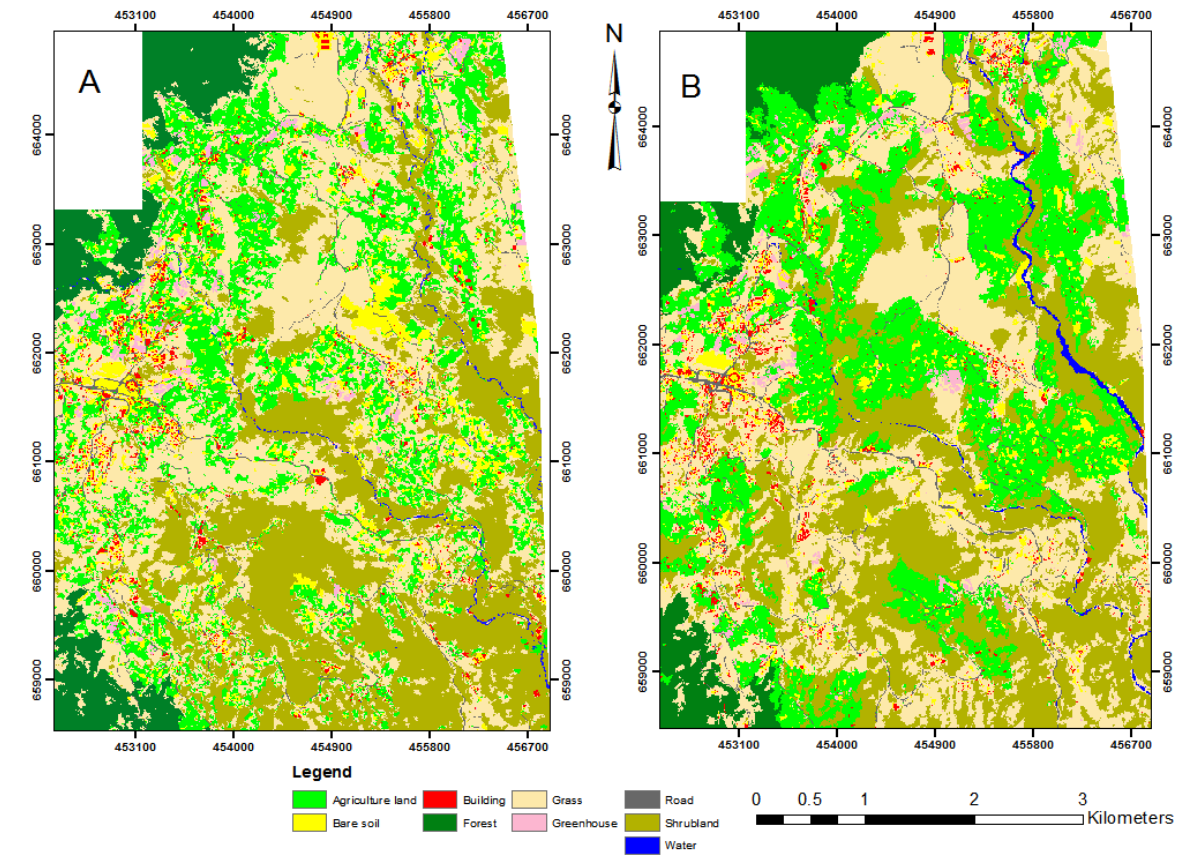
Figure 5. Classification results for Date 1 – 2014 (A) and Date 2 – 2018 (B)